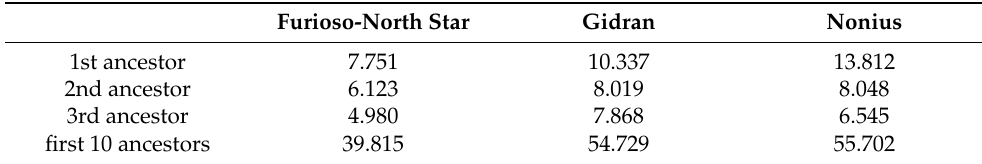
Table 4. Contribution of the ancestors to the gene pool of the reference populations (%).